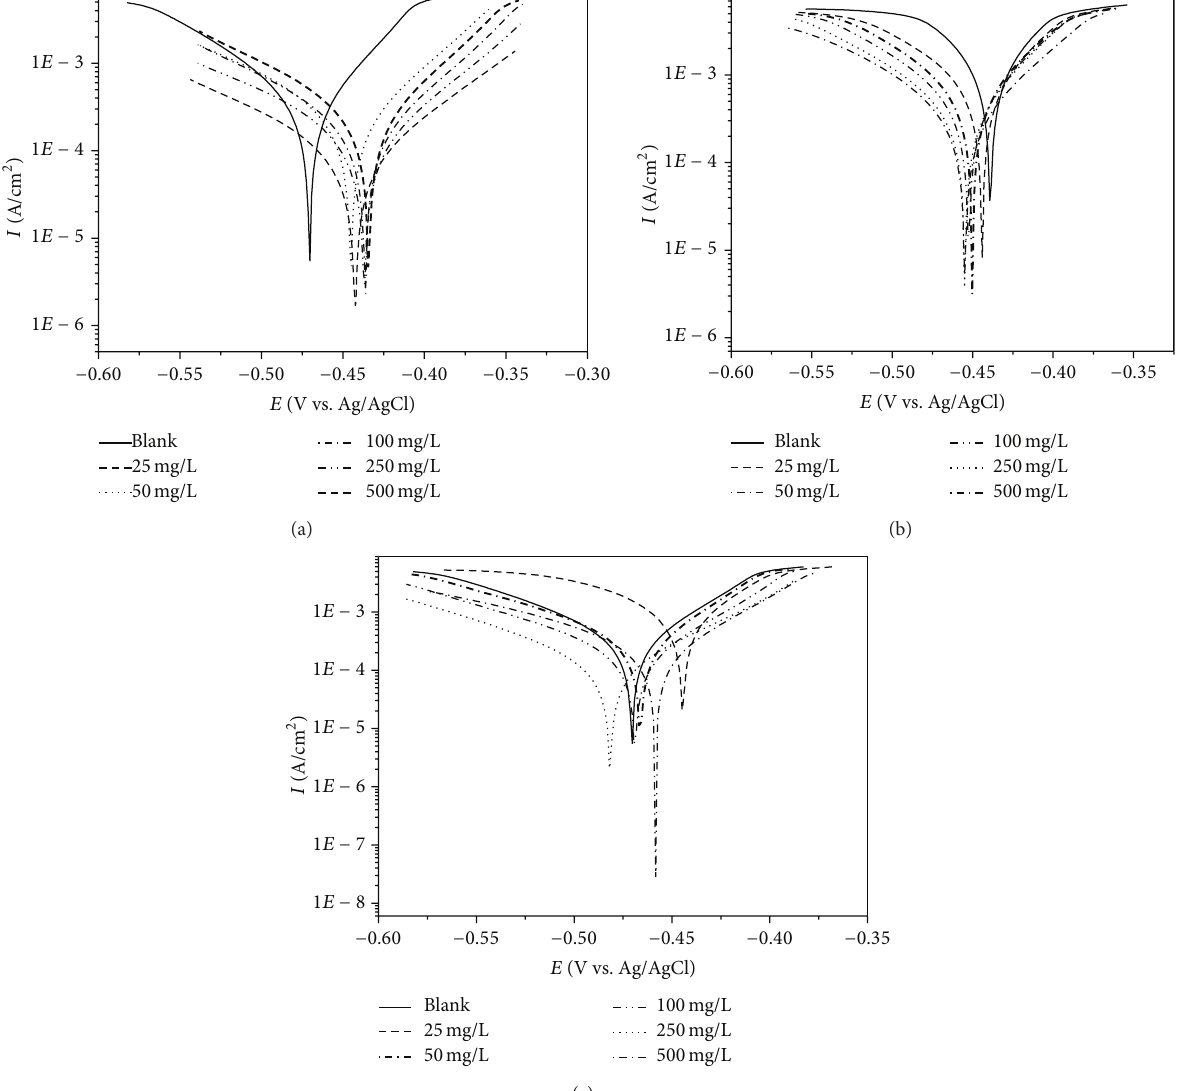
Figure 5: (a) Potentiodynamic polarization curves obtained for mild steel in 1M HCl in the presence and absence of different concentrations of PoAP. (b) Potentiodynamic polarization curves obtained for mild steel in 1M HCl in the presence and absence of different concentrations of PmAP. (c) Potentiodynamic polarization curves obtained for mild steel in 1M HCl in the presence and absence of different concentrations of